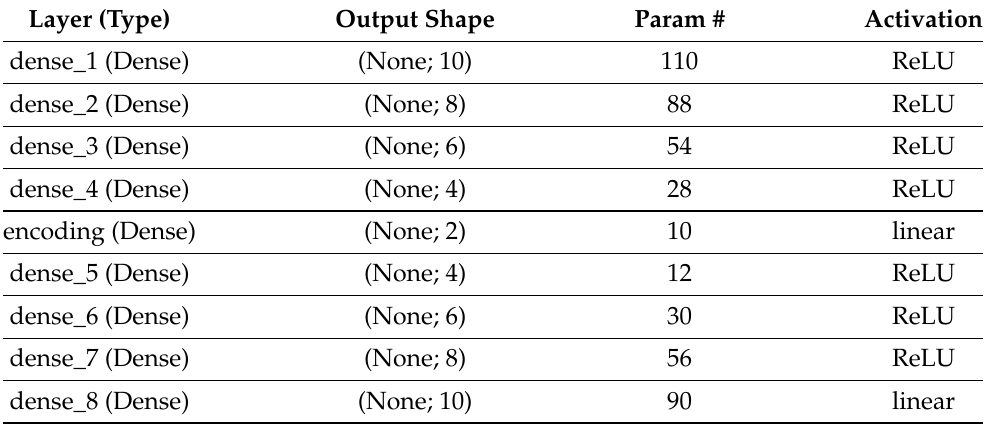
Table 3. Architecture of the AE used for the data sets from the 2019–2020 academic year.